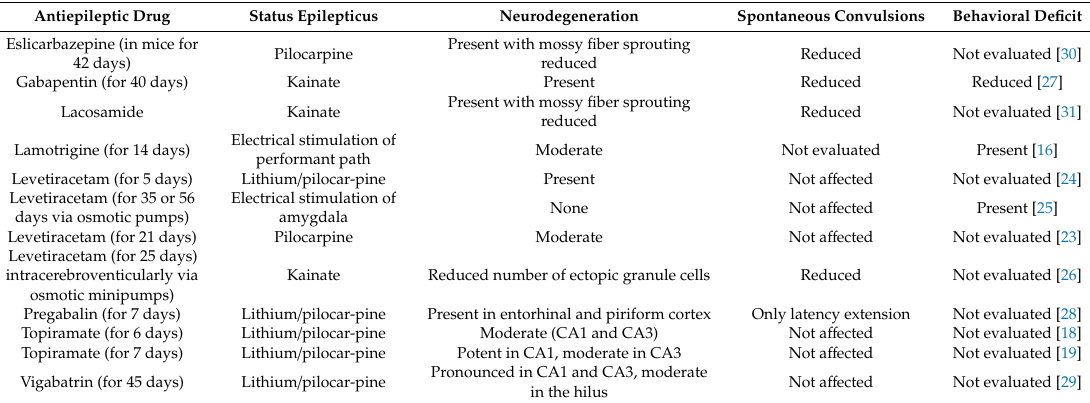
Table 2. Newer antiepileptic drugs and their influence on status epilepticus-induced neurodegeneration, spontaneous convulsions and behavioral deficit in rodents.